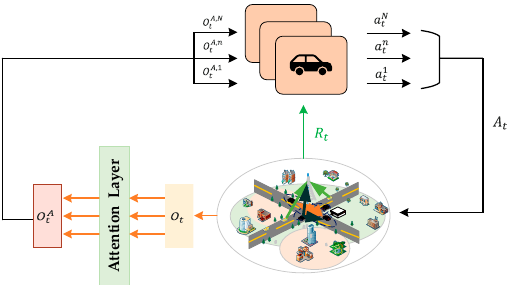
Figure 3. The basic AMARL for V2X communications.